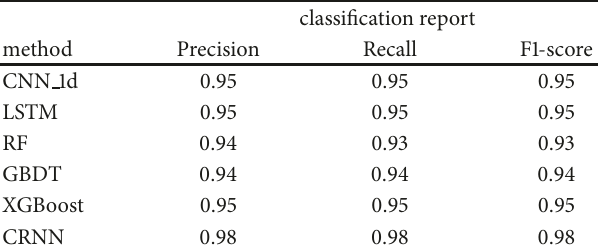
Table 5: Classification report of comparison